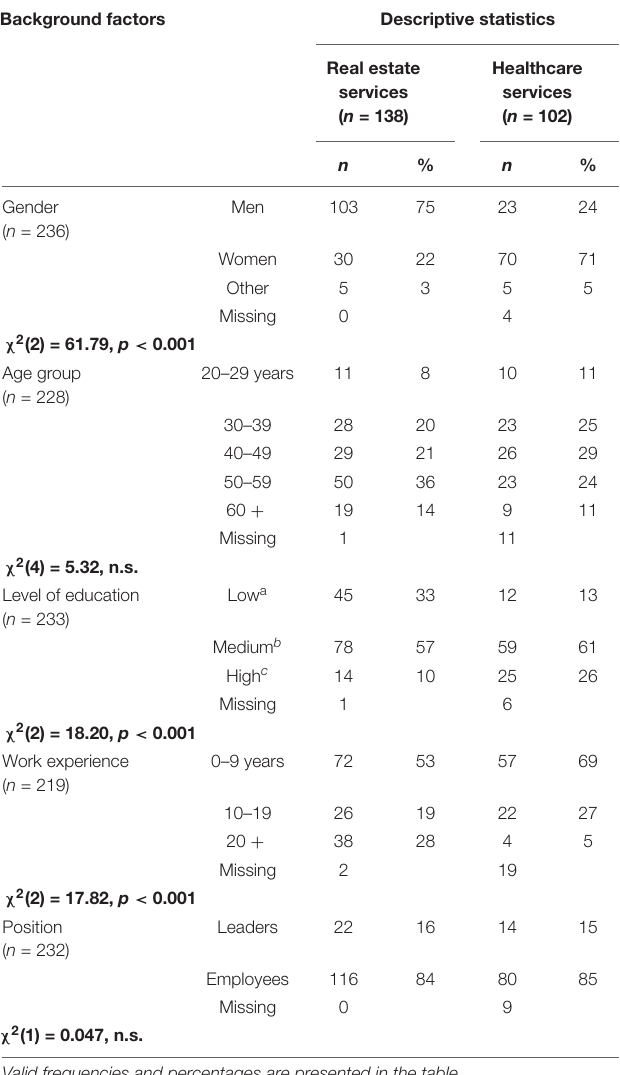
TABLE 1 | Descriptive statistics (frequencies, n; percentages, %) for background variables ( N =